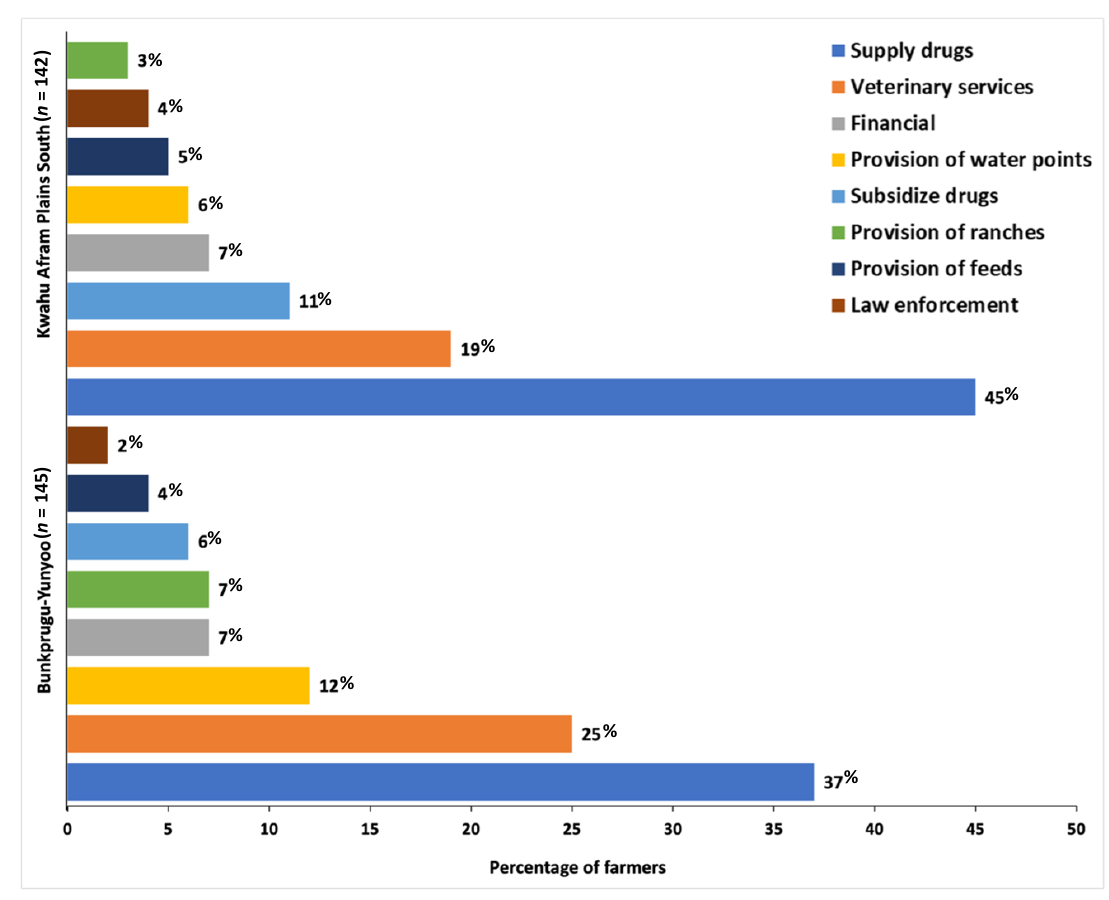
Figure 2. Singular priority support interventions required by cattle farmers (N = 287) to reduce losses. The percentages shown per bar were computed per study district: Bunkpurugu-Yunyoo ( n = 145) and Kwahu Afram Plains South ( n = 142).